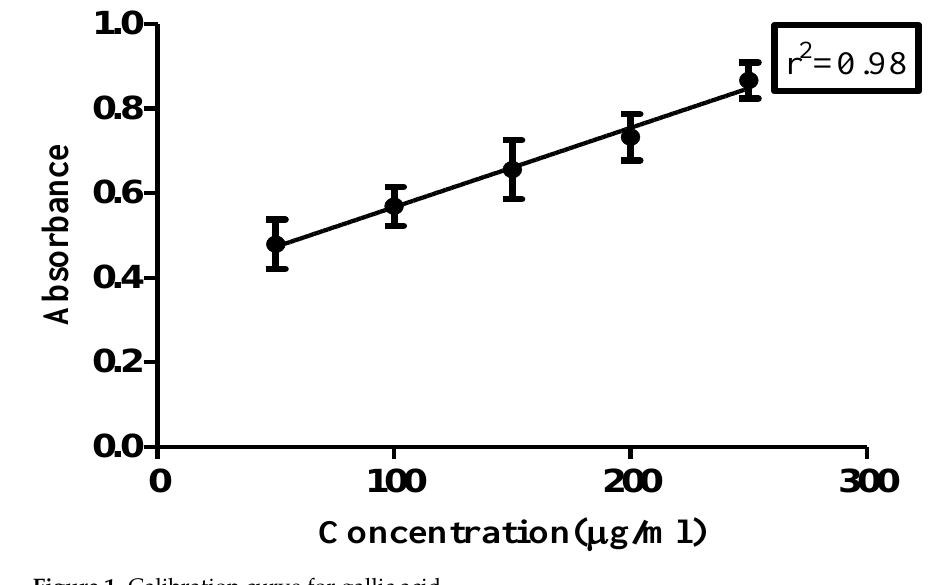
Figure 1. Calibration curve for gallic acid.